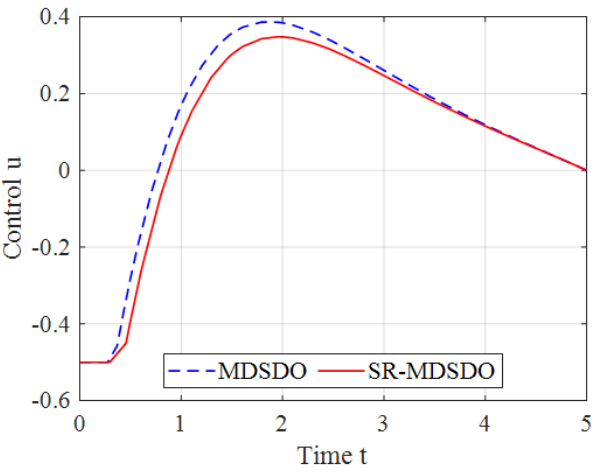
Figure 8. The comparison of control strategies between MDSDO and C-MDSDO. 402